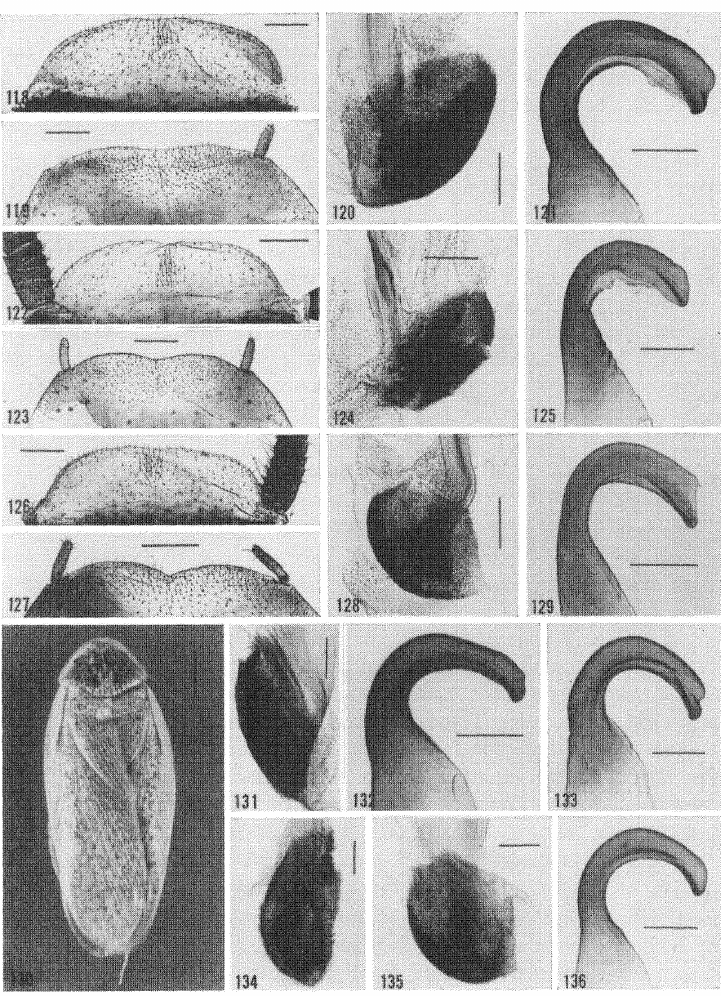
Figures 110-117. Calolamra gracilis. 110. (1 VM), lectotype, Ade- laide, S. A. 111-112. ? (139 MCZ), Blue Mrs., Hartley Vale, N.S.W. 111. Dorsal view. 112. Tegmen. 113-117. Supra-anal plate, hypandrium, and genitalia of lectotype shown in figure 110. Scale" Fig. 110 ram; Fig. 111 4 mm; Fig. 112 ram; Figs. 113-114 0.5 ram; Figs. 115- 117 0.2